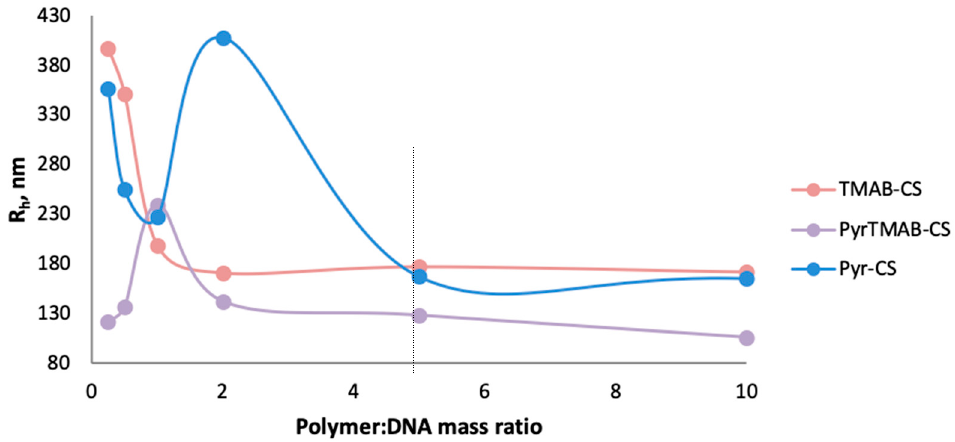
Figure5. Figure 5. The hydrodynamic radii of TMAB-CS:DNA, Pyr-CS:DNA, and PyrTMAB-CS:DNA polyplexes.